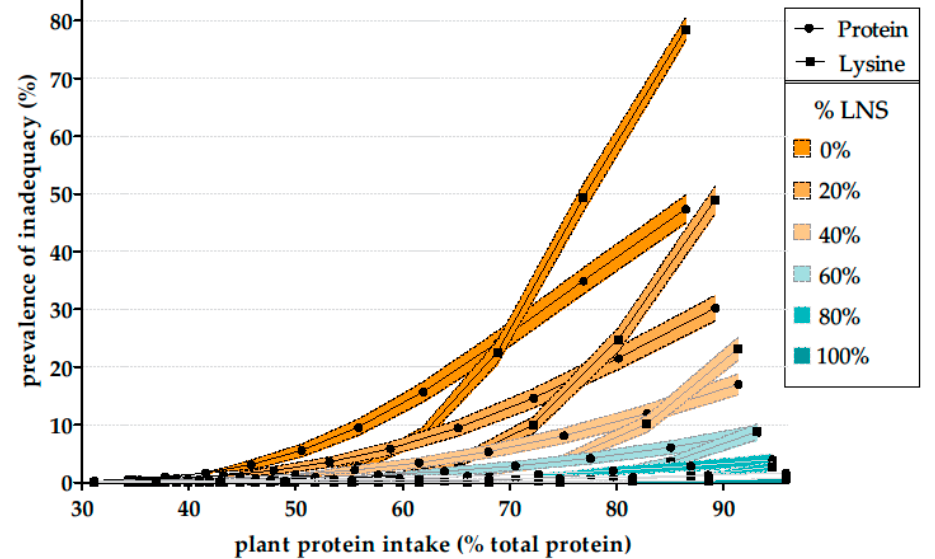
Figure 4. Prevalence of protein and lysine adequacy (% of the INCA2 study population, n = 1678) in